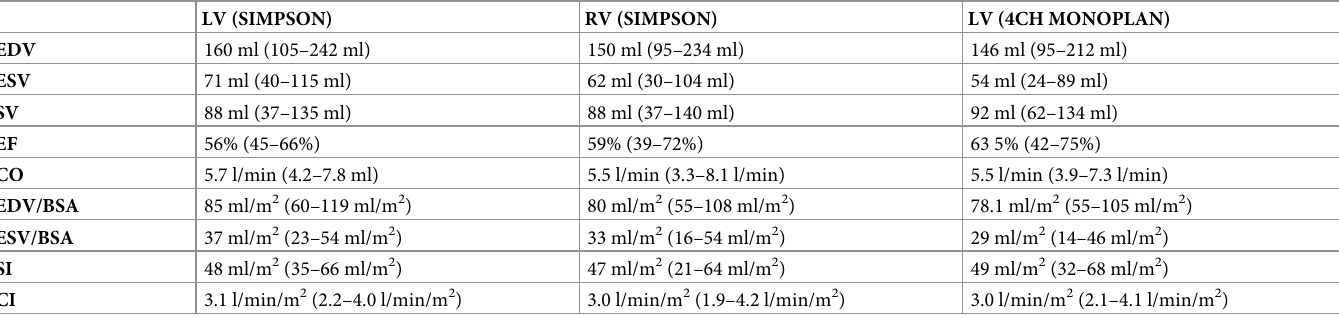
Table 3. Functional assessment of left and right ventricular function in healthy volunteers.